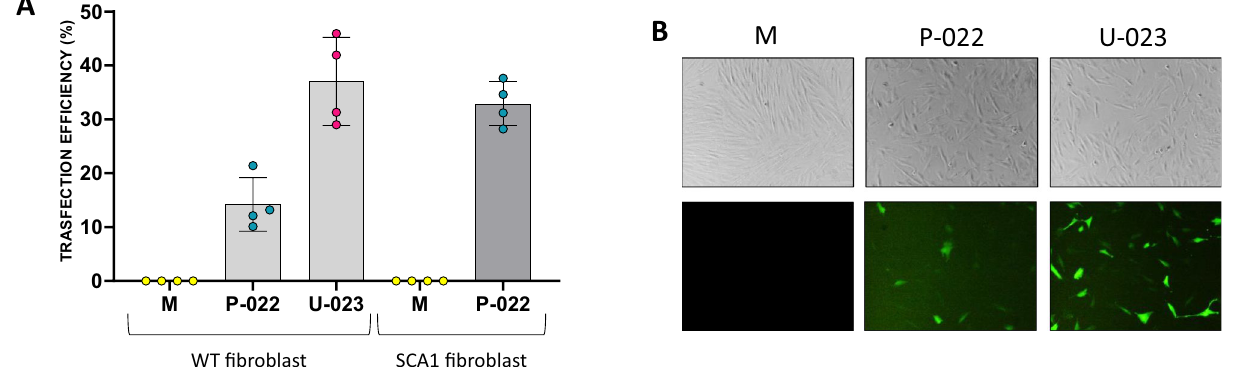
Figure 3. Evaluation of nucleofection efficiency in normal and SCA1 fibroblasts. The GFP-expressing plasmid was transfected into normal (AG21802, AG21754, AG21805) and SCA1 fibroblasts (SCA1N1, SCA1N5 and SCA1N6) by nucleofection using two different Amaxa Nucleofector Program, one with high viability (P-022) and the other with high efficiency (U-023). The latter proved to be too toxic for the SCA1 fibroblasts which after 24 h had a mortality greater than 90%. ( A ) The data, obtained by FACS analysis, represent the average of the experiments carried out on three cell lines of normal fibroblasts (AG21802, AG21754, AG21805) and on three lines of SCA1 fibroblasts (SCA1N1, SCA1N5, SCA1N6). ( B ) GFP expression in normal fibroblasts after 24 h from nucleofection, evaluated under fluorescence microscope. Values are mean ± s.e.m. from three independent